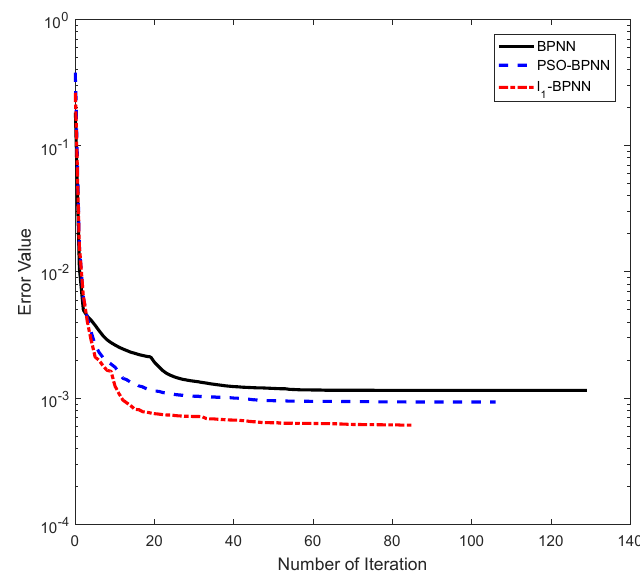
Figure 9. Training error curves of BPNN, PSO-BPNN and l 1 -BPNN.